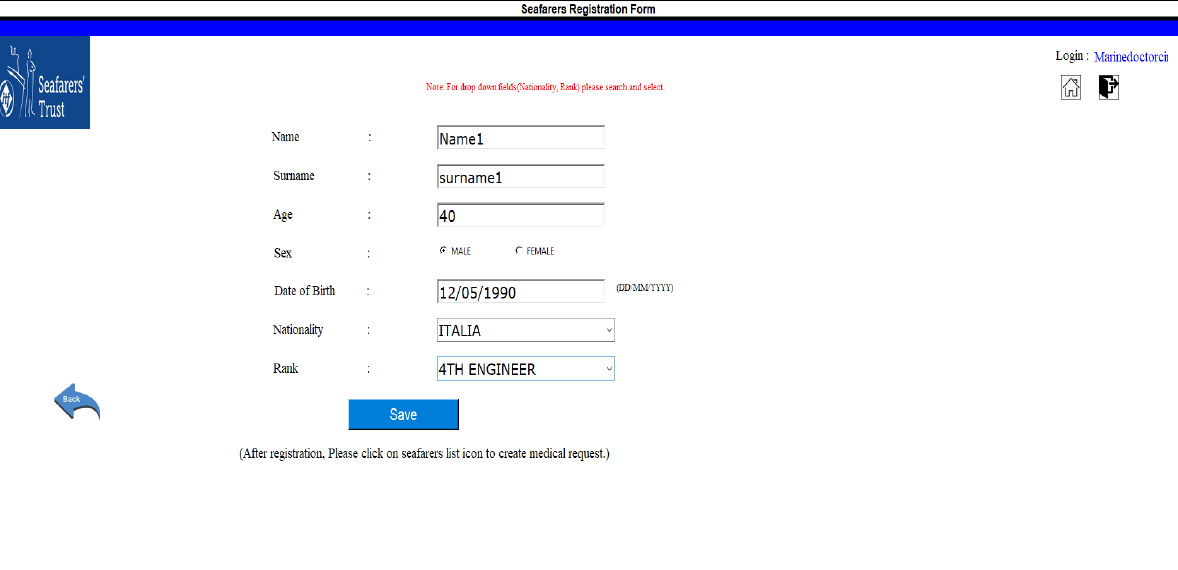
Figure 3. Seafarer registration form.